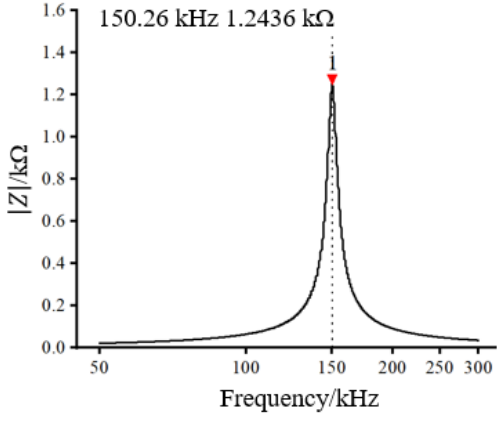
Figure 6. Resonant frequency measurement